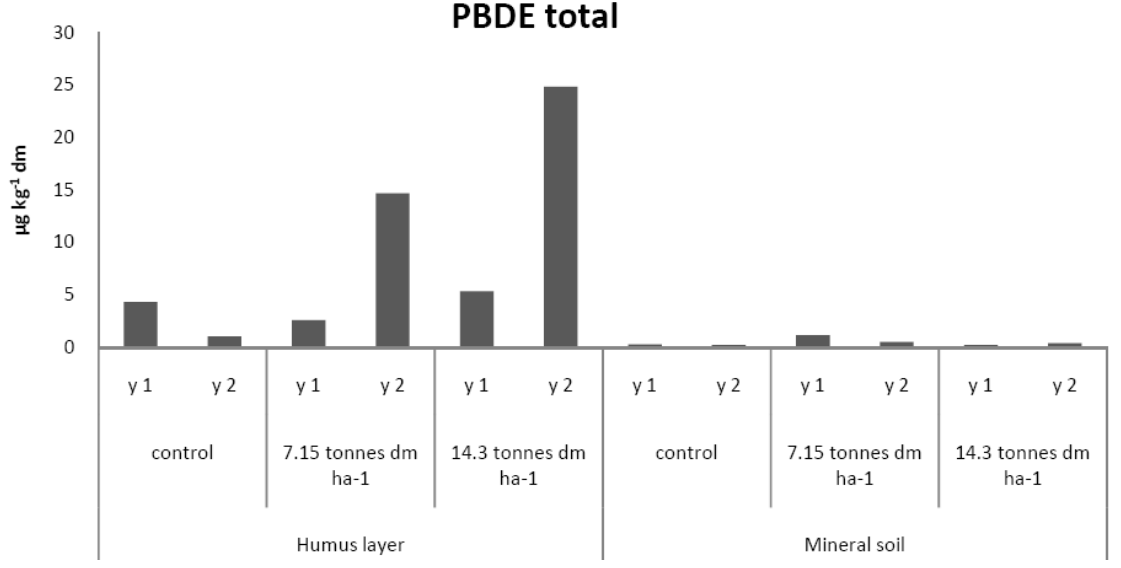
Figure 2. PBDE total levels in the small-scale experimental sites fertilized by hand